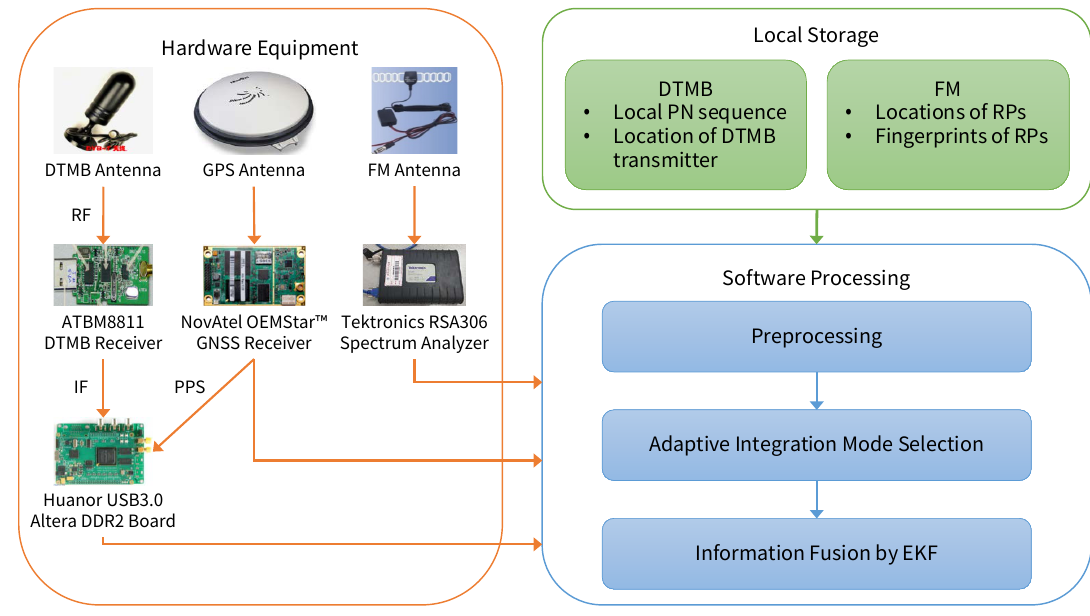
Figure 1. Overall architecture of the proposed